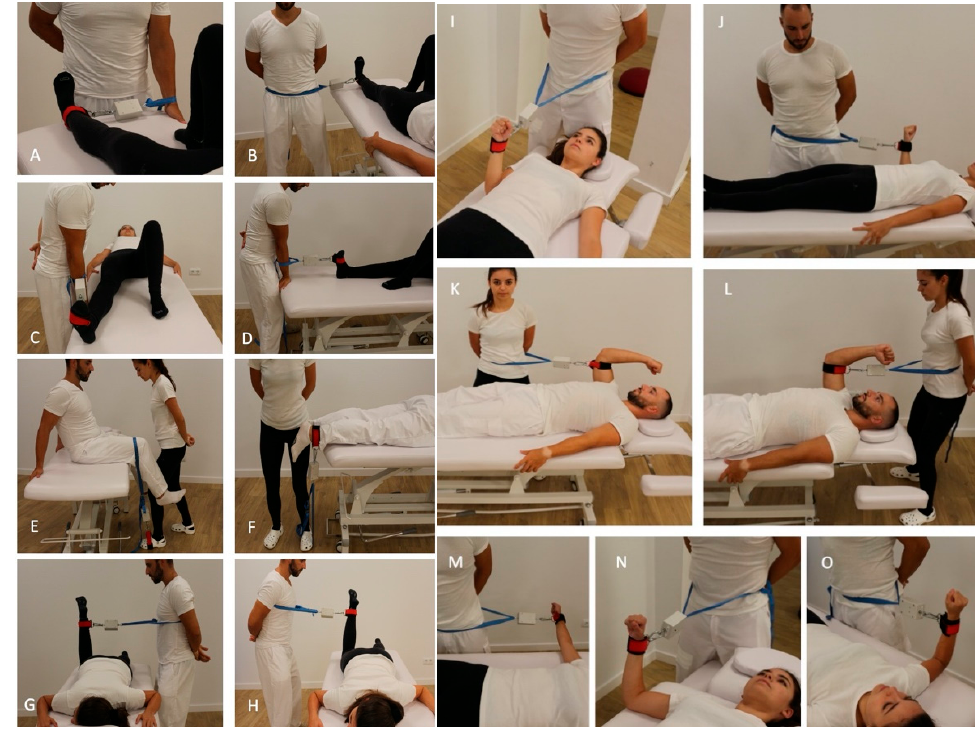
Figure A1. Isometric strength tests using pull HHD for: hip abduction ( A ), hip adduction ( B ), ankle flexion ( C ), ankle extension ( D ), hip flexion ( E ), hip extension ( F ), hip rotation internal ( G ), hip rotation external ( H ), elbow extension ( I ), elbow flexion ( J ), shoulder flexion ( K ), shoulder extension ( L ), shoulder abduction ( M ), shoulder internal rotation ( N ), and shoulder internal external ( O ).